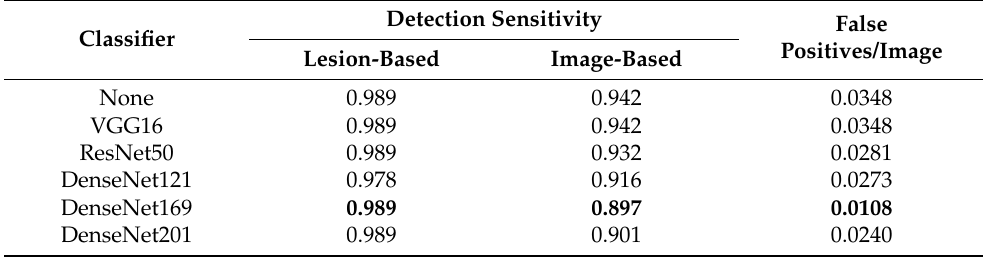
Table 2. Comparison of CNN architectures for false positive